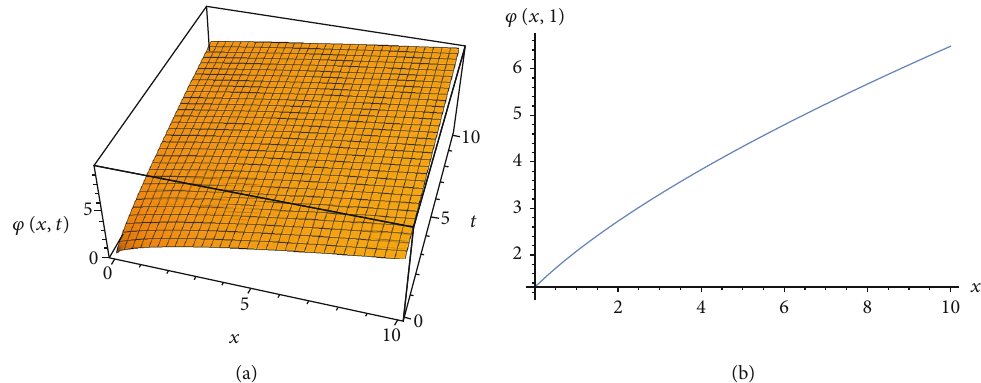
Figure 1: (a) The 3D graph of rational function solutions (Equation (34)) when α = 0 : 5 . (b) The corresponding 2D